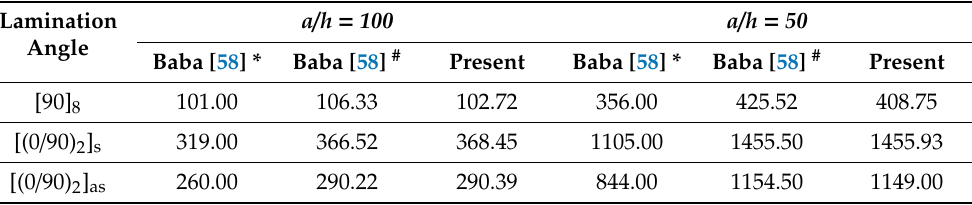
Table 4. Buckling load of two side clamped (CC) laminates.